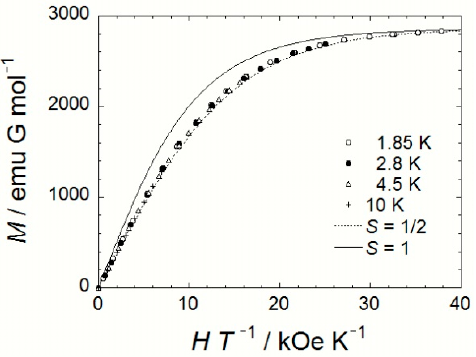
Figure 3. Magnetization isotherms of 2-BTHNN at 1.85 K (open circles), 2.8 K (closed circles), 4.5 K (open triangles), and 10 K (crosses).